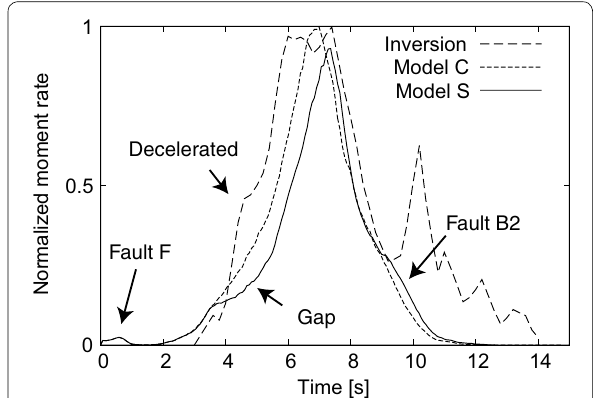
Fig. 10 Simulated and observationally inferred source time func- tions. Normalized moment rates are plotted for the strong motion inversion by the Japan Meteorological Agency, Model C and Model S. Both cases of Model C and Model S are normalized by the peak amplitudes of Model C. The inversion result is plotted 3 s behind the simulation results to compare their main peaks. Refer the text for details